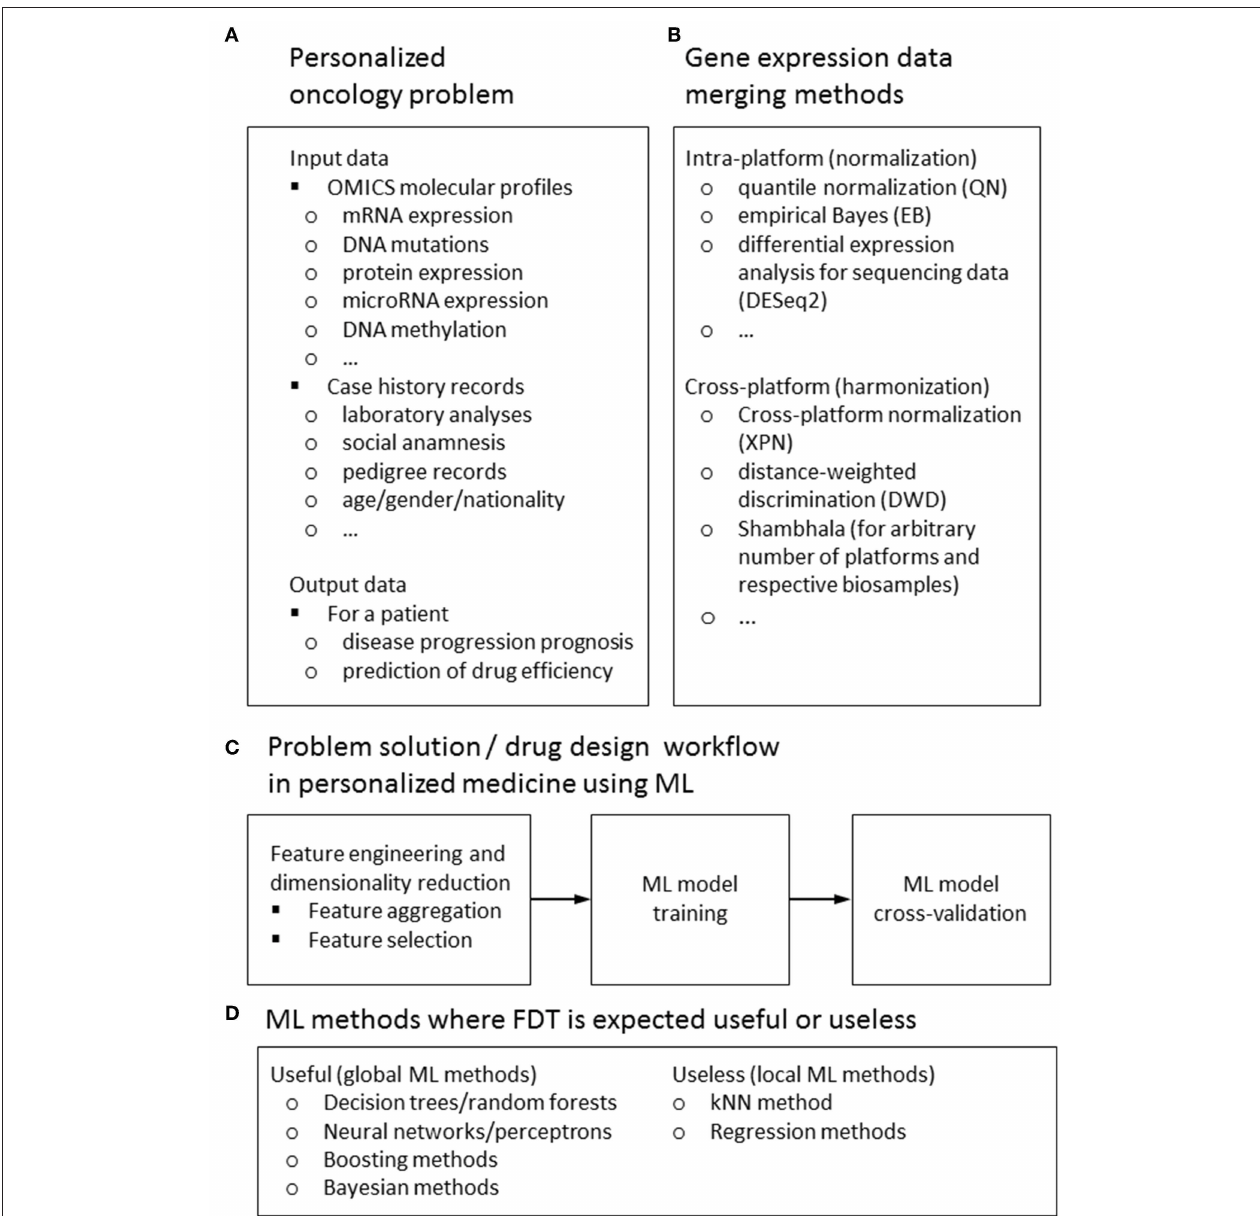
FIGURE 1 | Input and output data types (A) methods for feature harmonization (B) general workflow (C) for a ML-assisted solution of typical problem in personalized medicine; ML methods for those FDT is expected to be useful or useless (D)